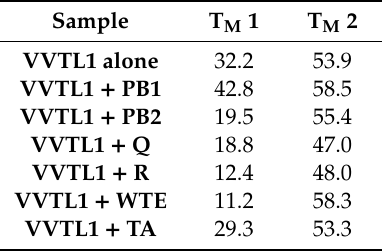
Table 2. Melting temperatures (T M ) values ( ◦ C) of VVTL1 alone and in presence of phenolic compounds. T M data were calculated using the software OriginPro 2018 (OriginLab Corporation), starting from the melting curves reported in Figure